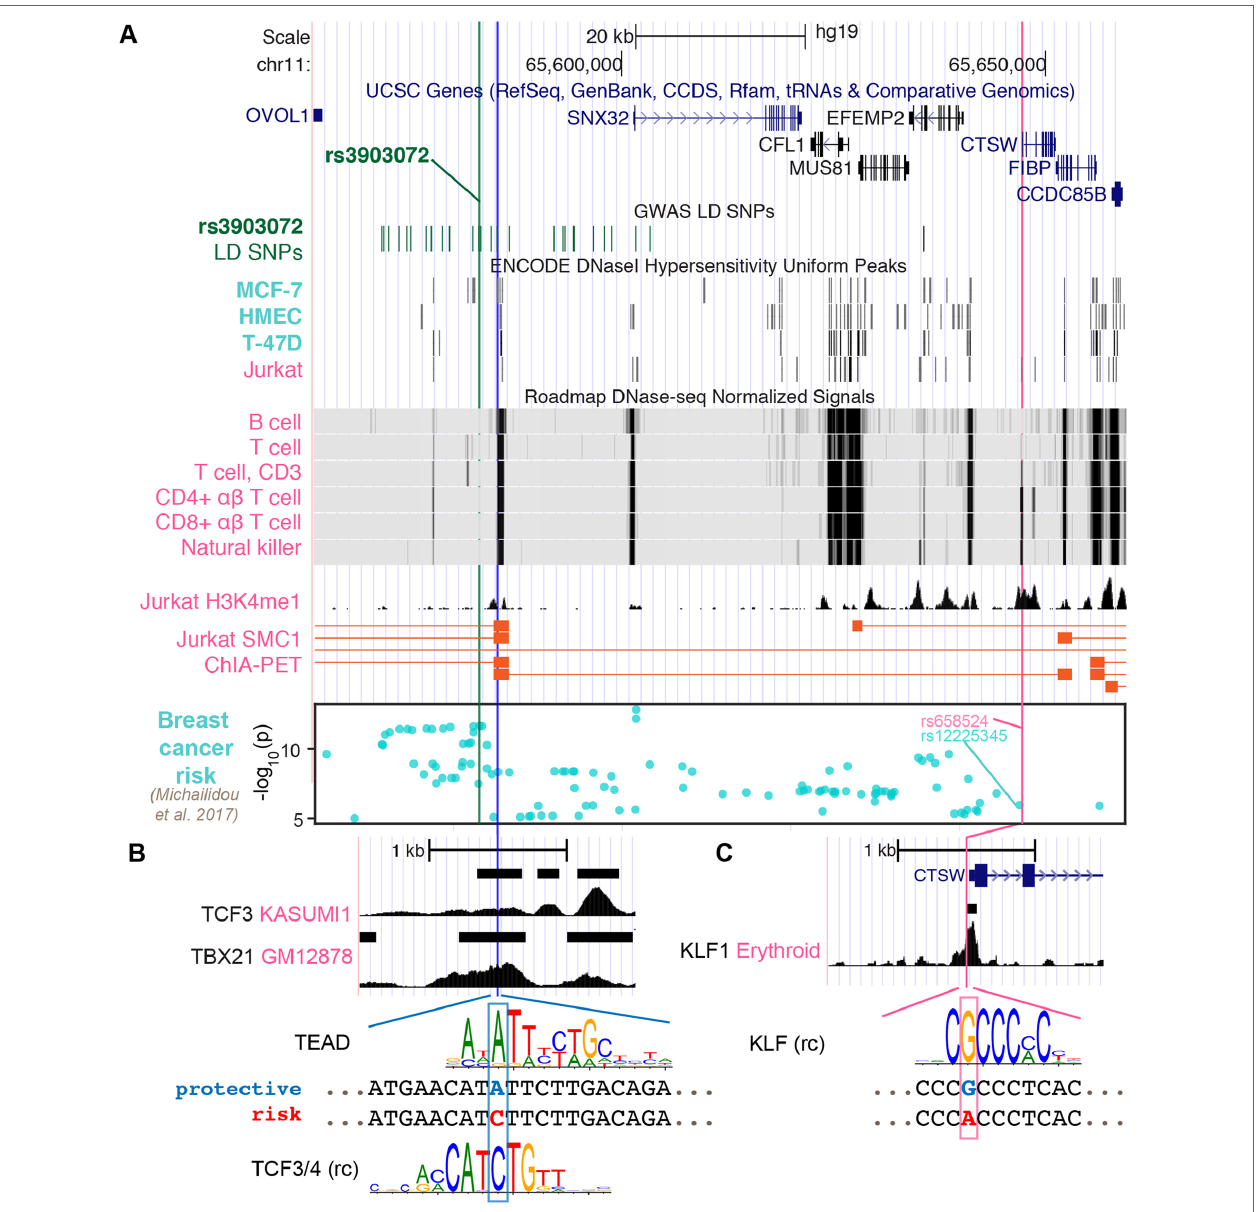
FIGURE 3 | Potential regulatory mechanisms for CTSW . (A) The genomic region ranging from the GWAS SNP rs3903072 to CTSW is shown, including the gene track, the GWAS LD SNPs, epigenetics information, and 3D chromatin interaction. The chromatin accessibility data are shown for breast-related cells and blood cells from ENCODE and Roadmap Epigenomics Project. The H3K4me1 modification track and the SMC1 ChIA-PET significant interactions in the Jurkat cell line are from GSE119439 and GSE68978. The bottom Manhattan plot shows the SNPs associated with breast cancer with p < 10 –5 . Three SNPs are marked: the GWAS SNP rs3903072 and the GWAS-linked putative enhancer SNP in blue and the CTSW promoter SNP in magenta. (B, C) Zoomed-in views of the two potential regulatory SNPs. For the GWAS-linked putative enhancer SNP, TCF3 ChIP-seq data in Kasumi1 and TBX21 ChIP-seq data in GM12878 are shown. Two candidate TF motifs predicted to be affected by the SNP are also shown, where the protective allele is marked blue and the risk allele red. For the CTSW promoter SNP, KLF1 ChIP-seq profile in erythroid cells is plotted, along with a KLF family motif (rc, reverse